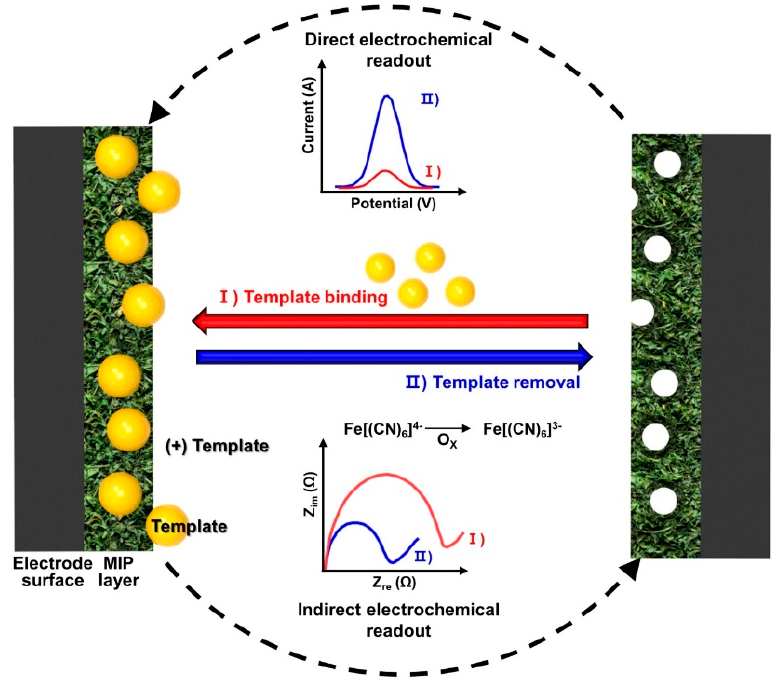
Figure 5. The basic concept of the electrochemical transduction on the MIP-based sensors using voltammetry test; the sensing procedure requires typical sequential steps, including the removal of the templates and rebinding of the target analytes on the MIP electrode. An electrochemical analytical method can be selected depending on the electroactive property of the analytes, which can be categorized either through direct detection (i.e., direct electrochemical readout) of the analyte or indirect detection (i.e., indirect electrochemical readout) using a redox probe, such as [Fe(CN)6] 3/4 − .